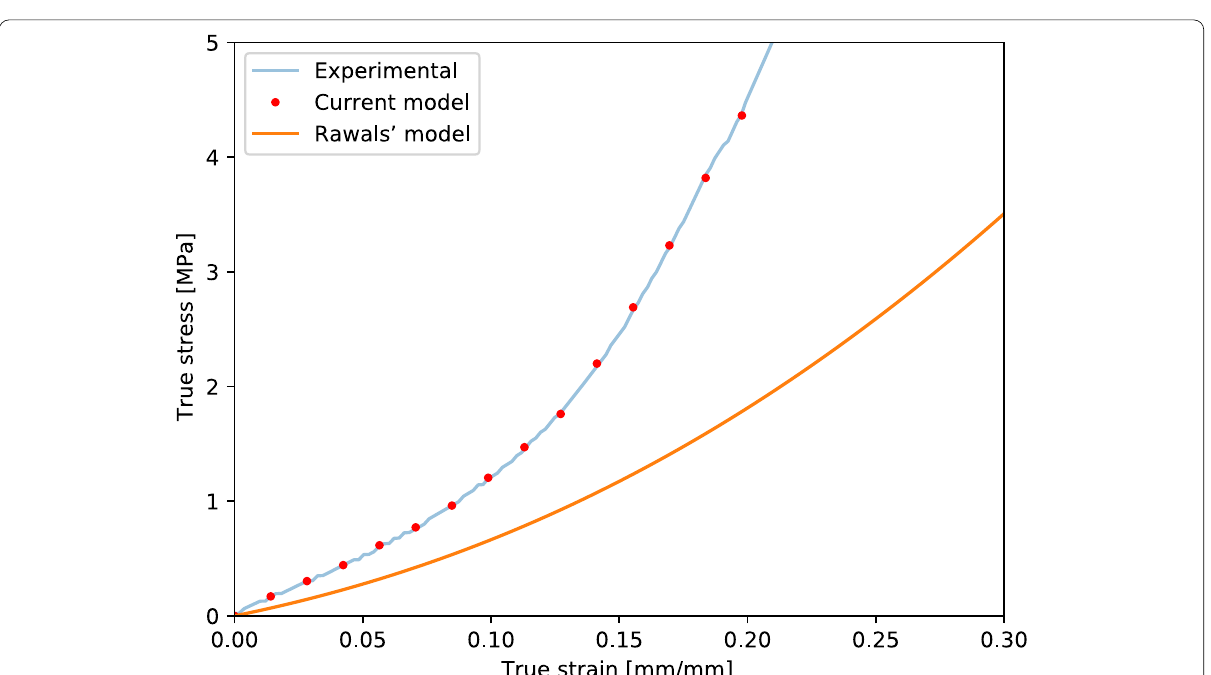
Fig. 14 True stress versus true strain for the model with the apparent kinetic friction coefficient, Rawals model compared to experimental results 47 for α i =